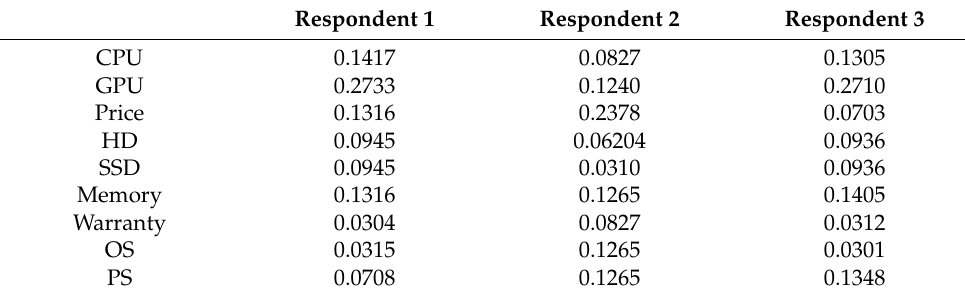
Table 9. Optimal weights of the seven criteria.